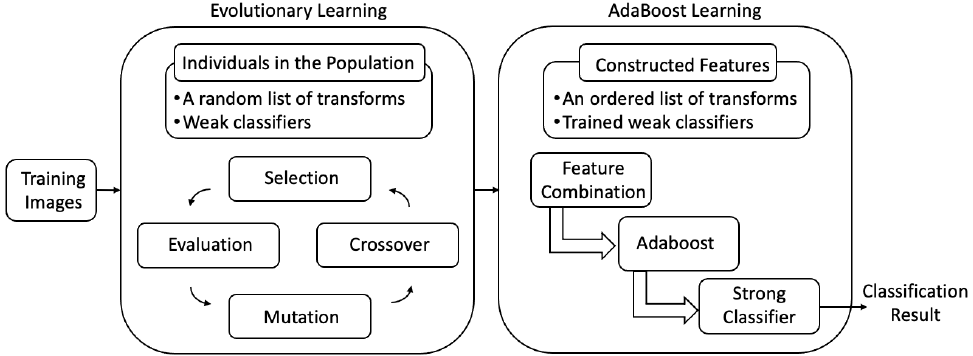
Figure 7. Flowchart of the evolutionary learning of the boosted features